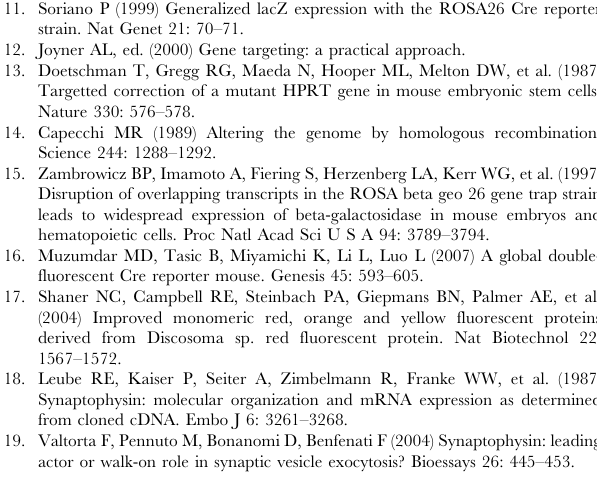
Inverse Gaussian (3P) distribution (red line). Both distributions indicate that the inter-puncta distances are assorted randomly. Inter-puncta intervals (in m m) are on the X-axis and the probability density function for observed intervals on the Y-axis. Figure S3 Statistics of the difference of the mean density for Dox treated and untreated samples. (A) Table listing Dox treatment conditions for all cerebellar granule cell axon segments analyzed in Figure 4E and 4F. Cells are listed in the order they appear from top to bottom in the plots in Figure 4. (B) Quantification of Syp- GFP mean density (the number of puncta per 100 m m) for Dox treated and untreated samples. Each green dot represents a data point. A black line marks the mean of each column. Error bars are 6 standard error of the mean (SEM). There is no significant difference between Dox treated and untreated samples in a given region of the GC (Mann Whitney; below PC, p = .3726; PC, p = .4121; above PC, p= .7921; PF, p =.3311), suggesting that Syp-GFP expression in untreated samples does not significantly alter synaptic density. (C) Histogram of the coefficient of variation (CV= SD/mean) of presynaptic densities for Dox treated and untreated samples in all regions of the GC. Groups are labeled on the X-axis and CV values on the Y-axis. The CV varies little between Dox treated and untreated samples, indicating that Syp- GFP expression in the untreated condition does not affect presynaptic